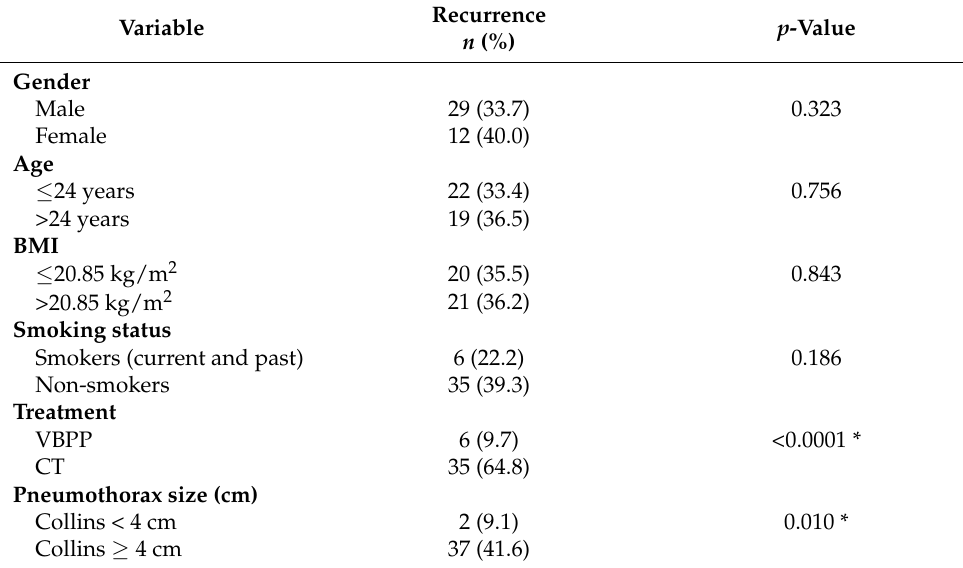
Table 2. Patient clinical characteristics and recurrence rates of PSP.